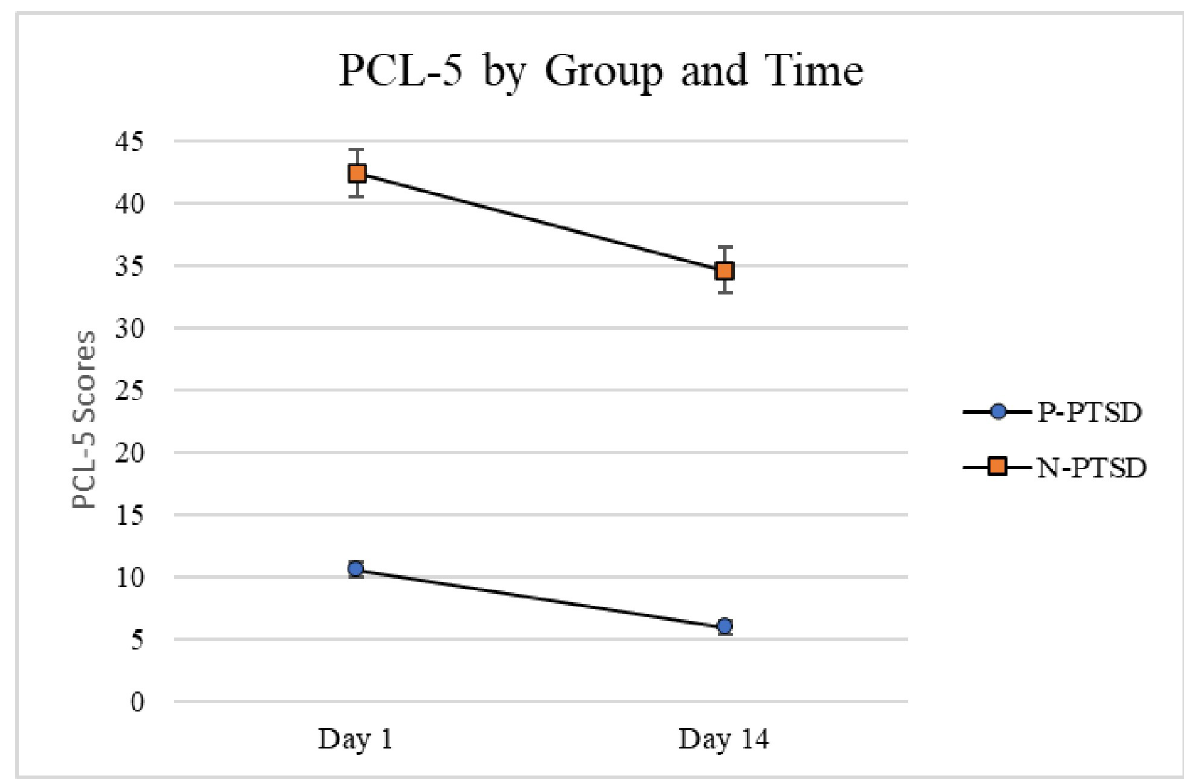
Fig 4. PCL scores at Day 1 and Day 14 as a function of P-PTSD. Average PTSD checklist scores shown with standard error bars as a function of day and provisional PTSD (n = 24) and No PTSD (n = 212) groups.